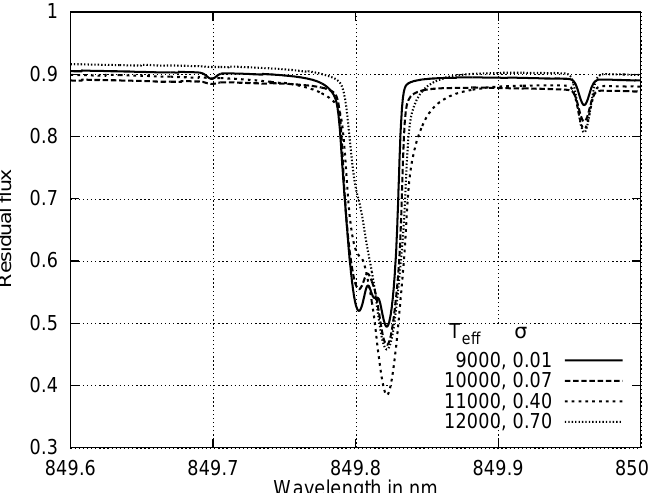
Fig. 5. Residual flux of Ca II IR triplet component at 849.8 nm in the model stellar atmospheres with log g = 4 : 0 and T eff = 9000, 10 000, 11 000 and 12 000 K, for different (cid:27) values (shown in the insert in the units of 10 (cid:0) 16 cm 2 ).